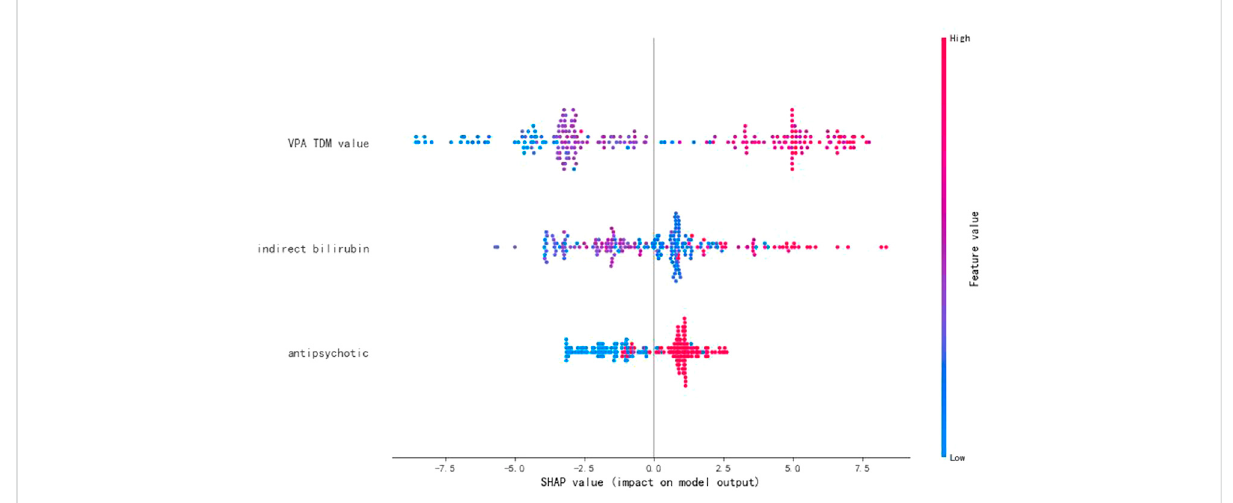
FIGURE 4 SHAP valuesof theimportant variables. The dot color is redder when thefeature value gets higher and bluer when the feature value gets lower. When the SHAP value gets higher, the impact of the variable on model output is larger.